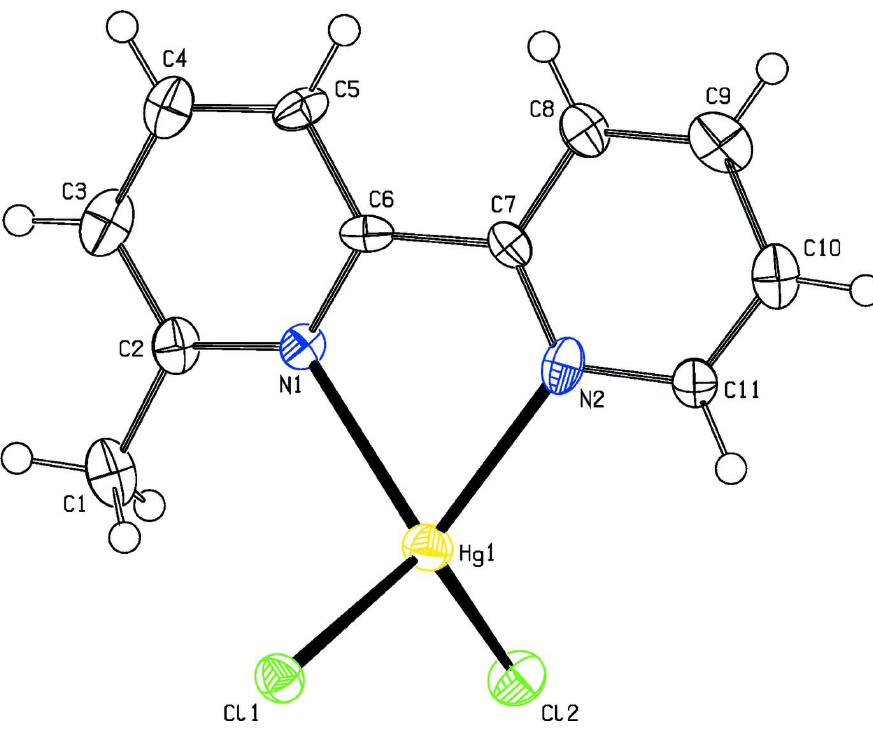
Figure 1 The molecular structure of the title molecule, with the atom-numbering scheme. Displacement ellipsoids are drawn at the 50% probability